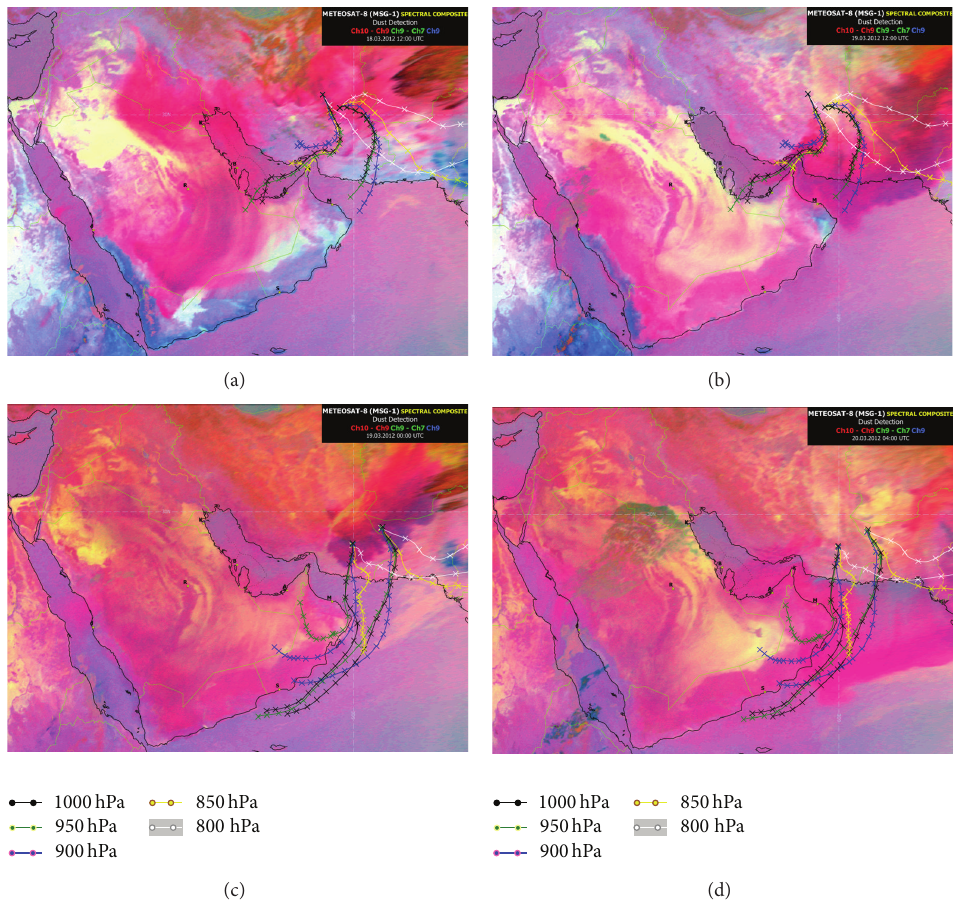
Figure 5: System out for the dust storm event over Sistan and Baloushistan basin starting from March 18, 2012.